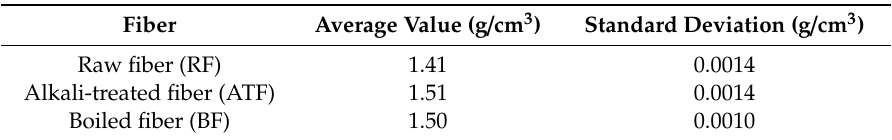
Table 1. Absolute density of